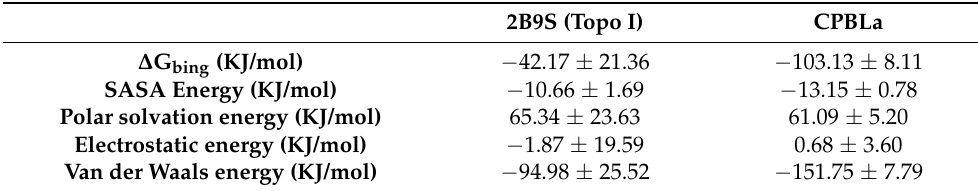
Table 5. Binding energy and interaction parameters calculated by